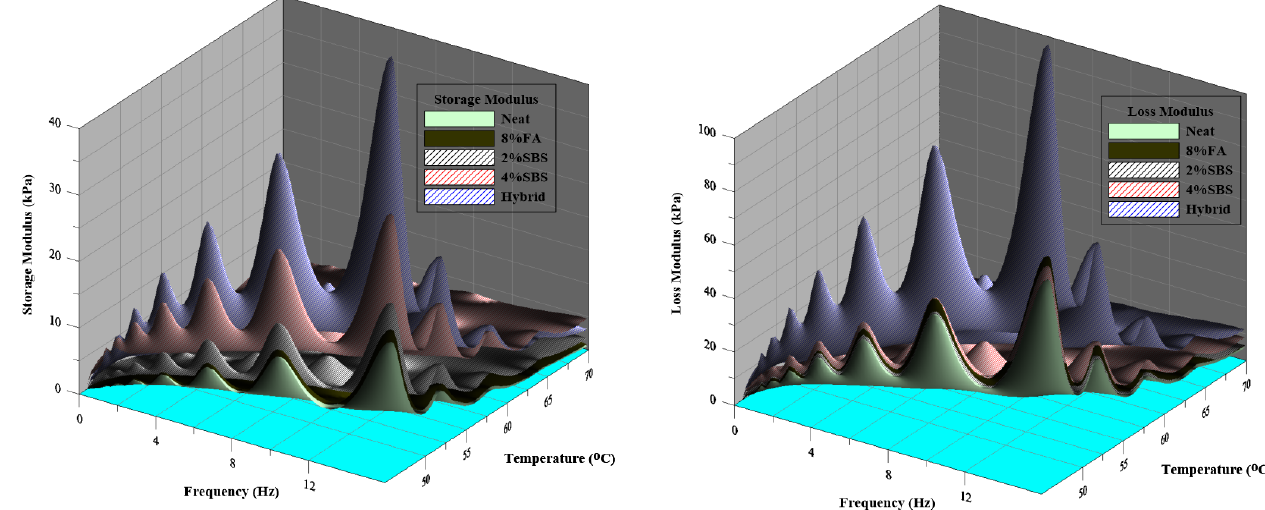
Figure 7. Temperatures and frequencies effects on the G (cid:48) and G (cid:48)(cid:48) of SBS and FA binders.